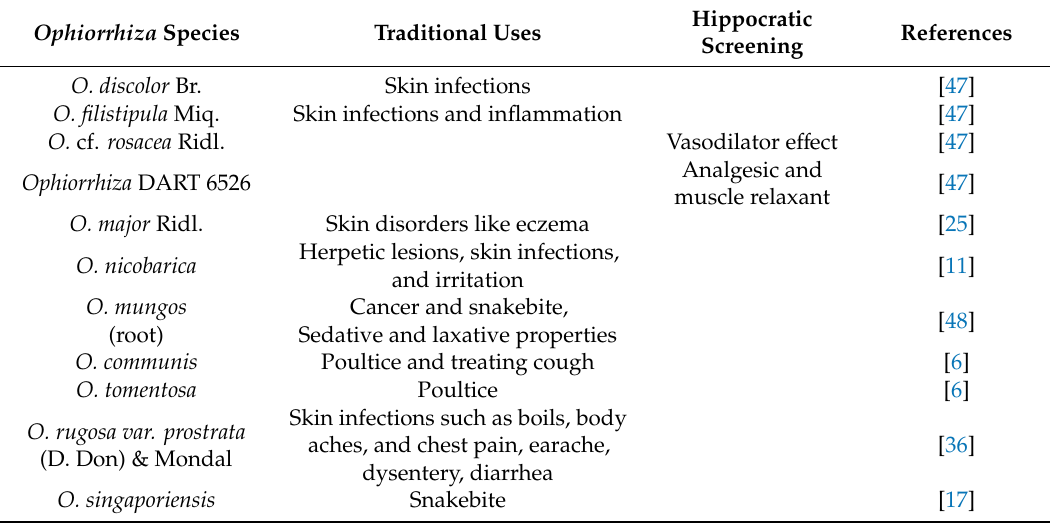
Table 2. Traditional uses of Ophiorrhiza